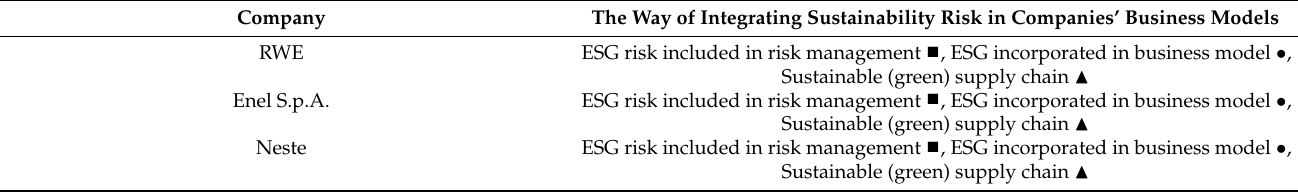
Table 18. The way of integrating sustainability risk in the selected